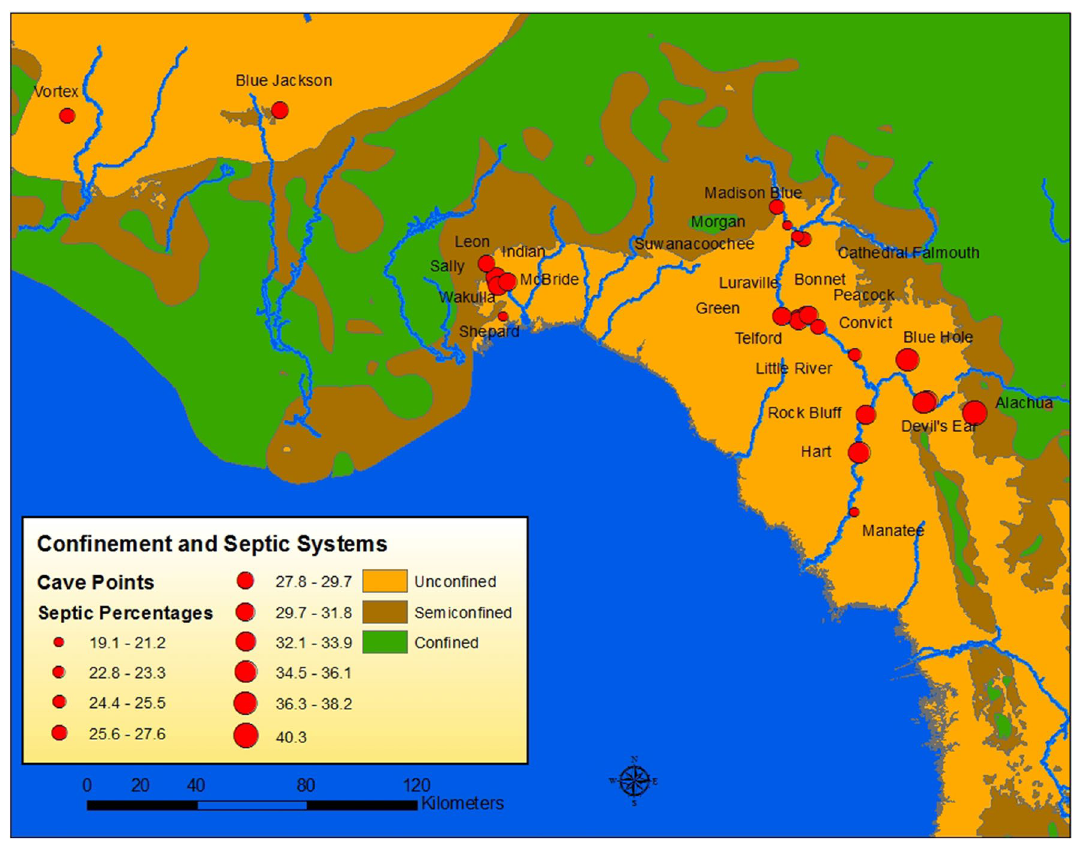
Fig. 9 Percentage of septic systems around